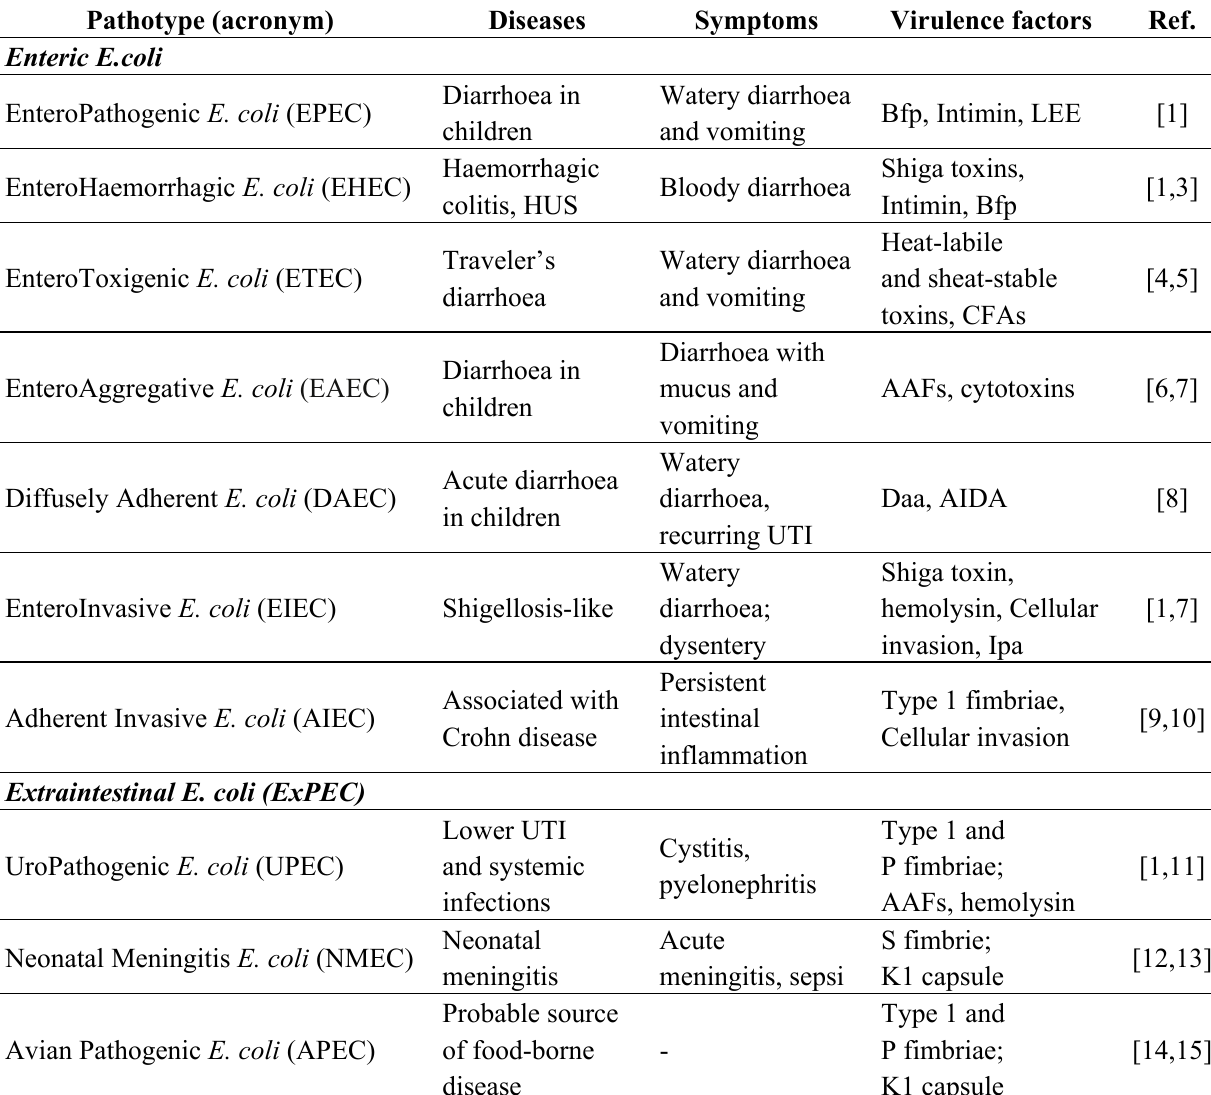
Table 1. E. coli pathogenic